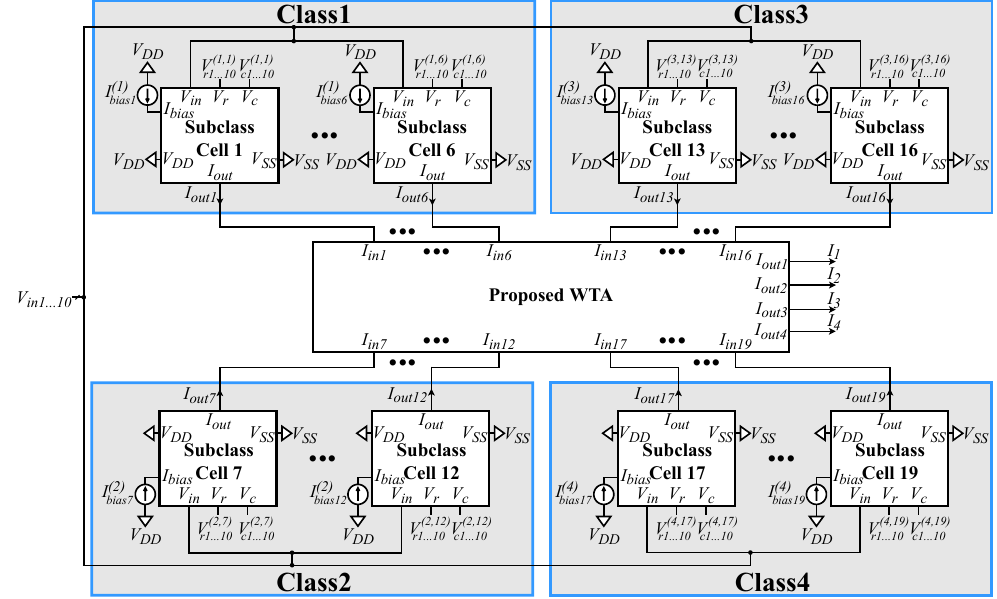
Figure 7. The implementation of the analog centroid-based classifier. The output currents of each multivariate bump circuit representing each sub-class are inserted into the WTA circuit to indicate the winning